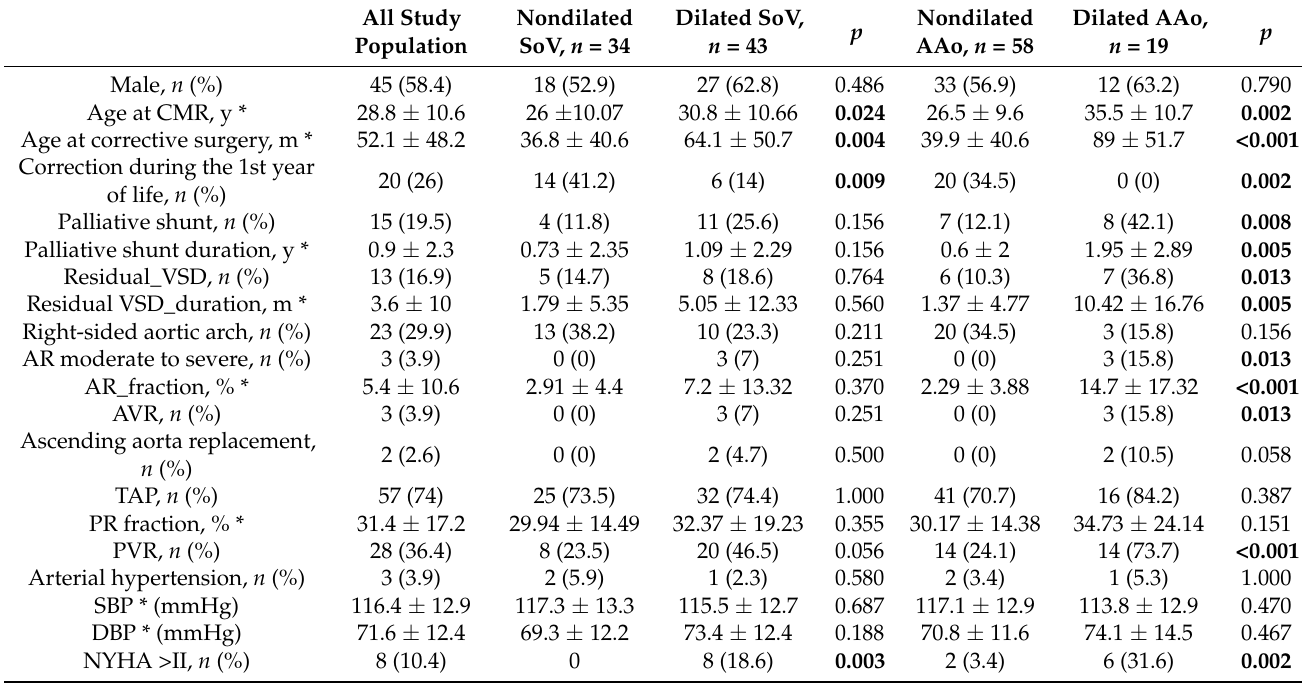
Table 2. Basic characteristics of patients with dilated sinus of Valsalva and ascending